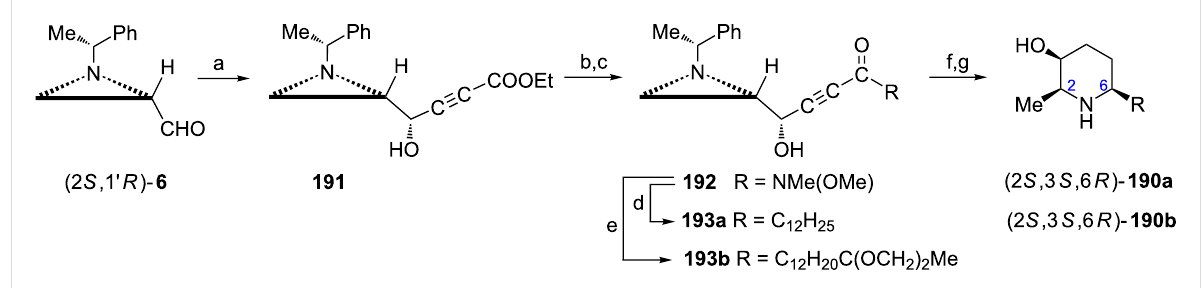
Scheme 51: Syntheses of (+)-deoxocassine ((2 S ,3 S ,6 R )- 190a , R = C 12 H 25 ) and (+)-spectaline ((2 S ,3 S ,6 R )- 190b , R = C 12 H 24 C(O)Me). Reagents and conditions: a) HC ≡ CCOOEt, LiHMDS, THF, − 78 °C, 2 h; b) TfOTBDMS, 2,6-lutidine, CH 2 Cl 2 , 0 °C, 10 min.; c) MeONHMe, iPrCl, THF, − 10